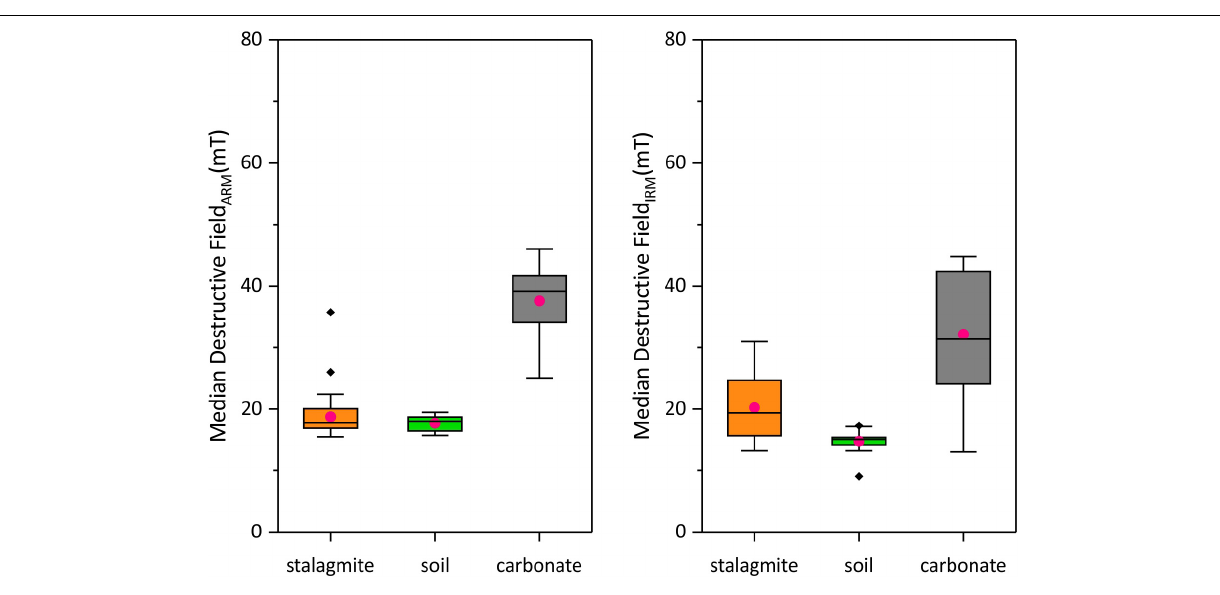
FIGURE 6 | Magnetic coercivity results from the adjustment of skewed generalized Gaussian (SGG) functions from the detailed demagnetization curves of ARM and IRM for stalagmites (orange), soil (green), and carbonates